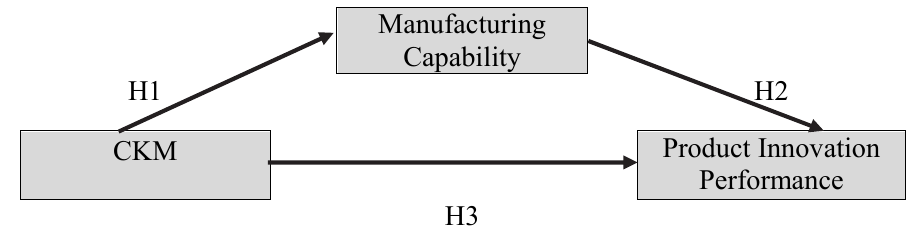
Fig. 5. The framework of the